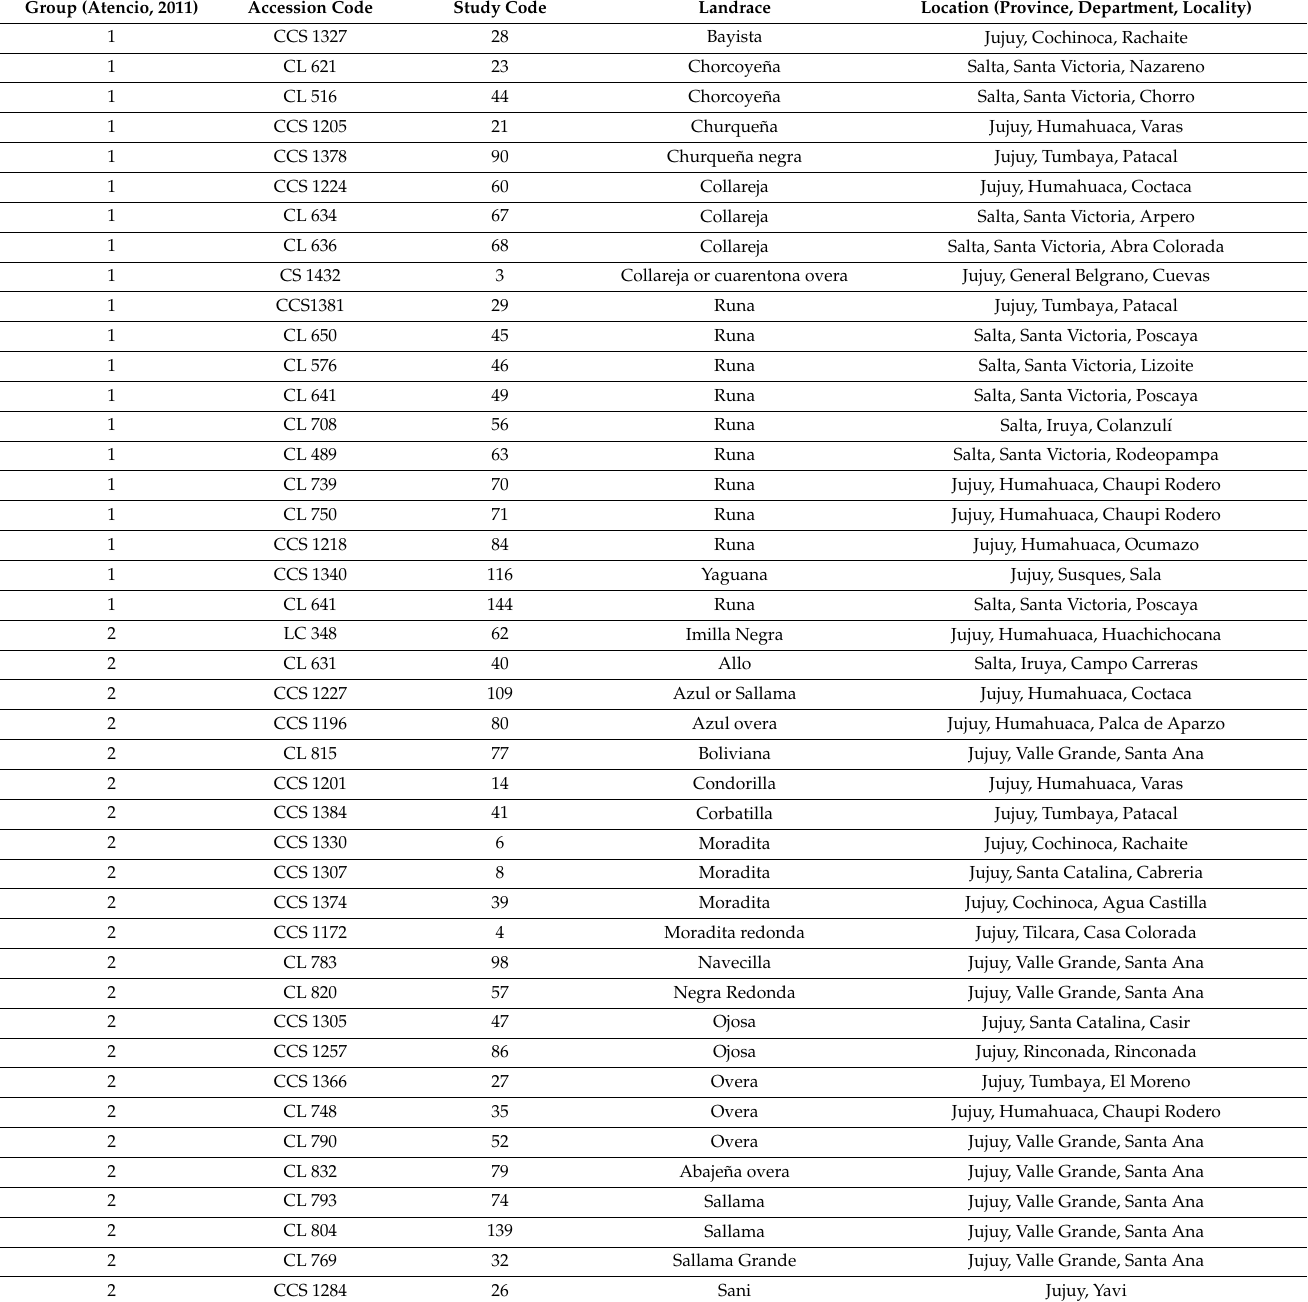
Table 1. Collection used for the present